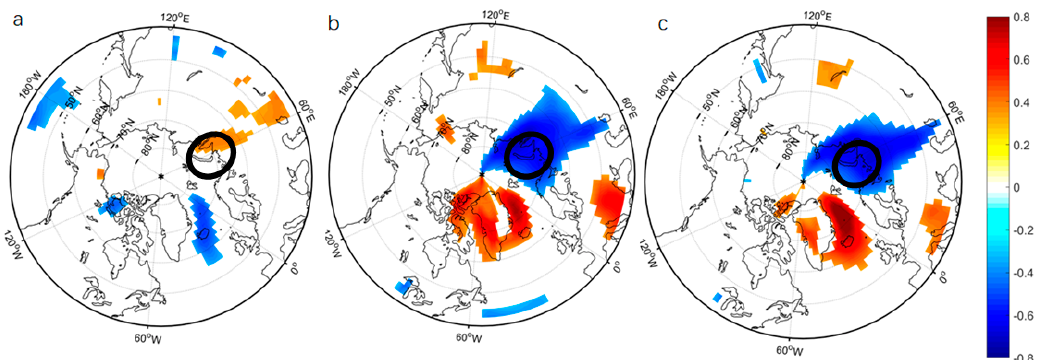
Figure 7. ( a ) Correlation coefficient distribution between the winter meridional water vapor transport in the northern hemisphere at 850 pha and autumn eastern Siberian Sea ice extent; ( b ) The Norway–Barents-centered SLP in winter; ( c ) The Norway–Barents-centered 500 hpa geopotential height in winter. The colored regions passed the t test with a confidence level of 90%. All the data have been de-trended.